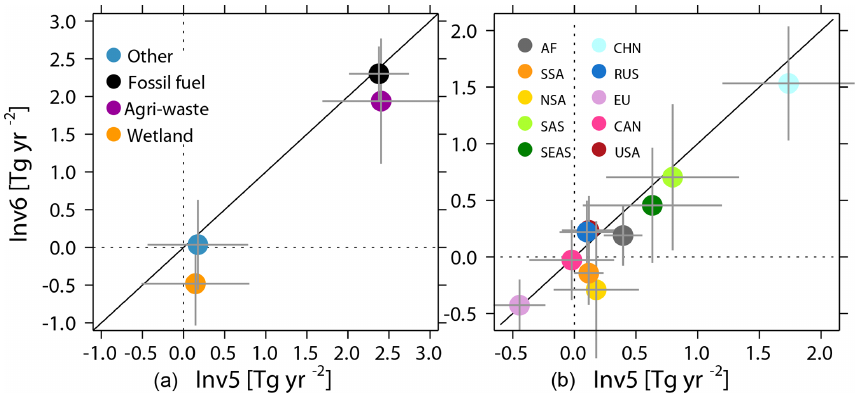
Figure 9. Comparison between Inv5 ( x axis) and Inv6 ( y axis) estimated global total CH 4 emissions trends (Tgyr − 2 ) between 2004 and 2015 for the four categories (a) and over the 10 continental regions (b) . The error bars show the trend with 95% confidence